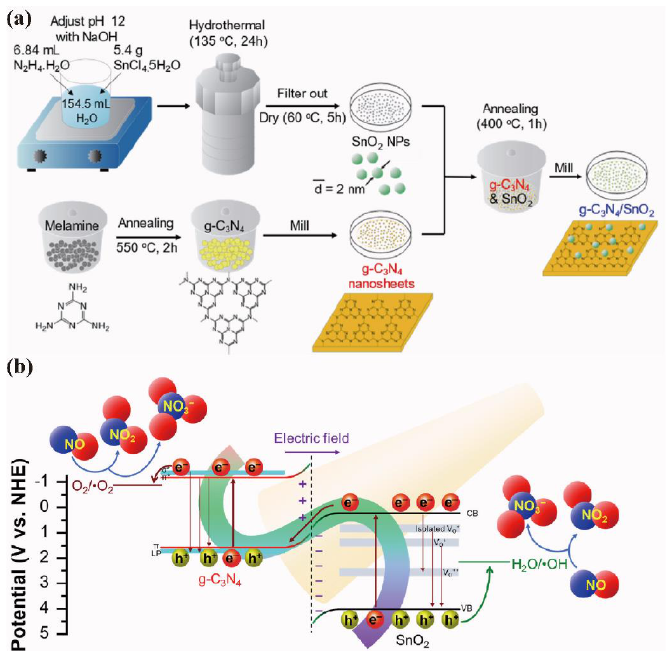
Figure 15. ( a ) Schematic illustration for the preparation of g − C 3 N 4 /SnO 2 S − scheme heterojunction using a hydrothermal and annealing strategy. ( b ) The proposed mechanism of S − scheme to improve the photocatalytic performance of g − C 3 N 4 /SnO 2 [127]. Copyright 2021, Elsevier.